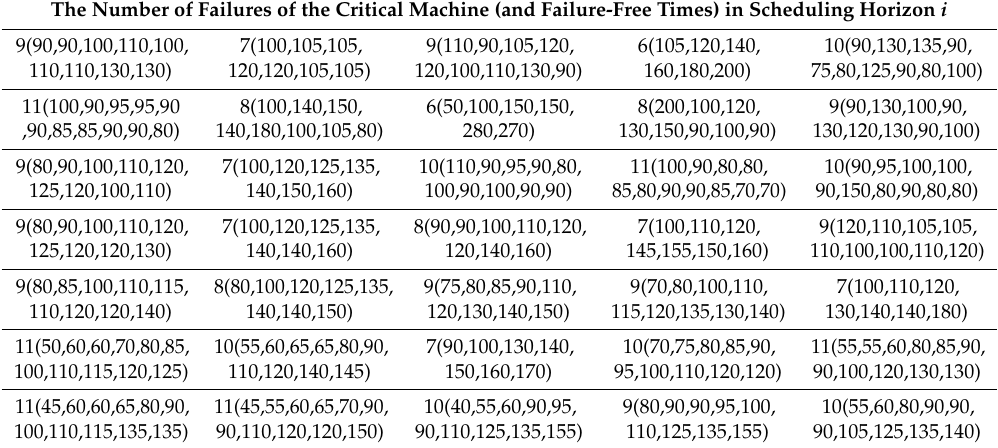
Table 1. Failure-free times x i , k of the critical machine collected for scheduling horizons, i = 1,2, ... ,35. The Number of Failures of the Critical Machine (and Failure-Free Times) in Scheduling Horizon